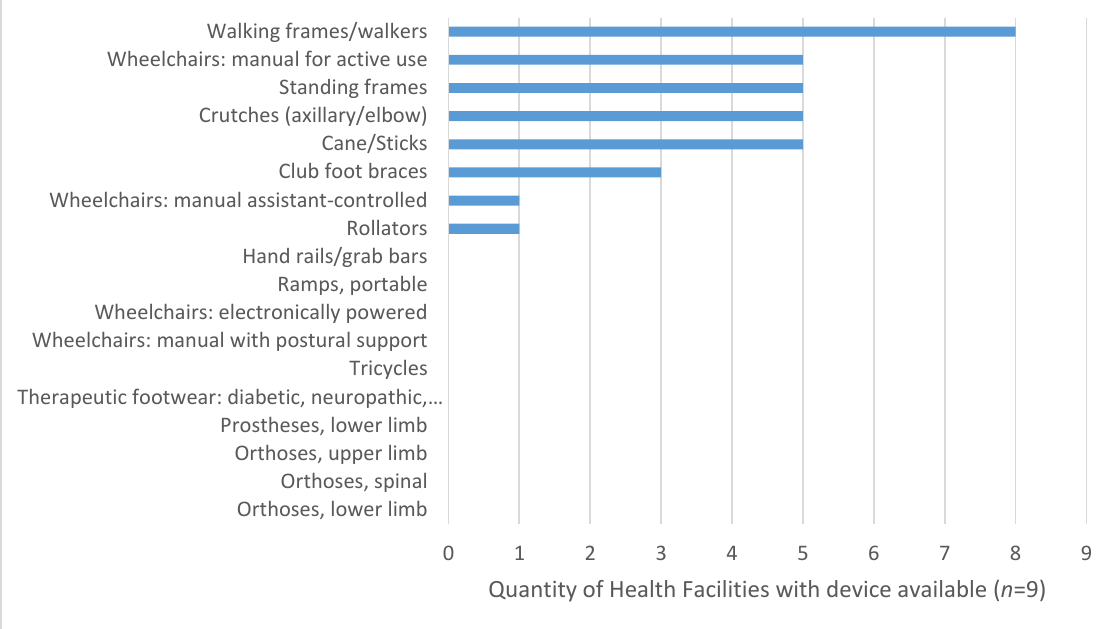
Figure 3. Number of health facilities with availability of mobility ‐ related assistive devices. Table 2. Availability of assistive devices according to